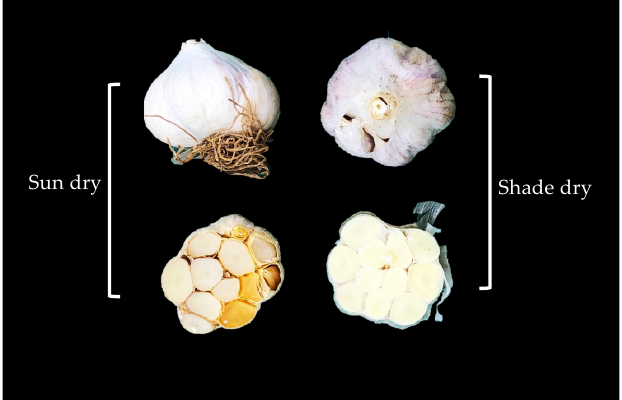
Figure 3. Garlic morphology after sun and shade drying.